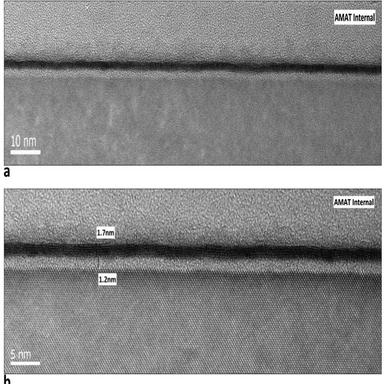
TEM for 7a. Chem-Ox IL and 700C PNA. 7b. Chem-Ox IL and 900C PNA TEM.